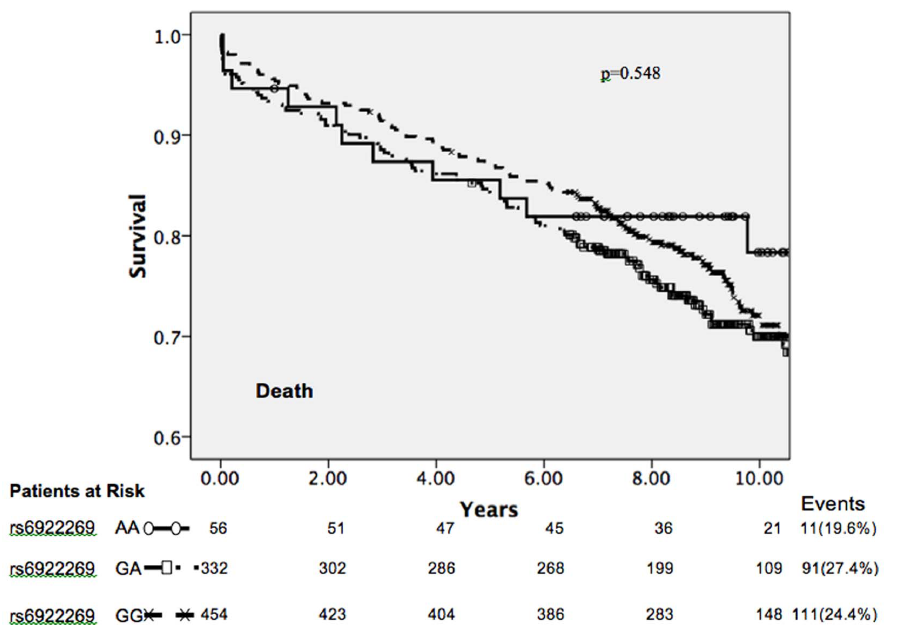
Figure 4. Kaplan-Meier survival analysis of CDCS cohort stratified by rs6922269 genotype a) in patients with above median BNP levels, b) in patients with below median BNP